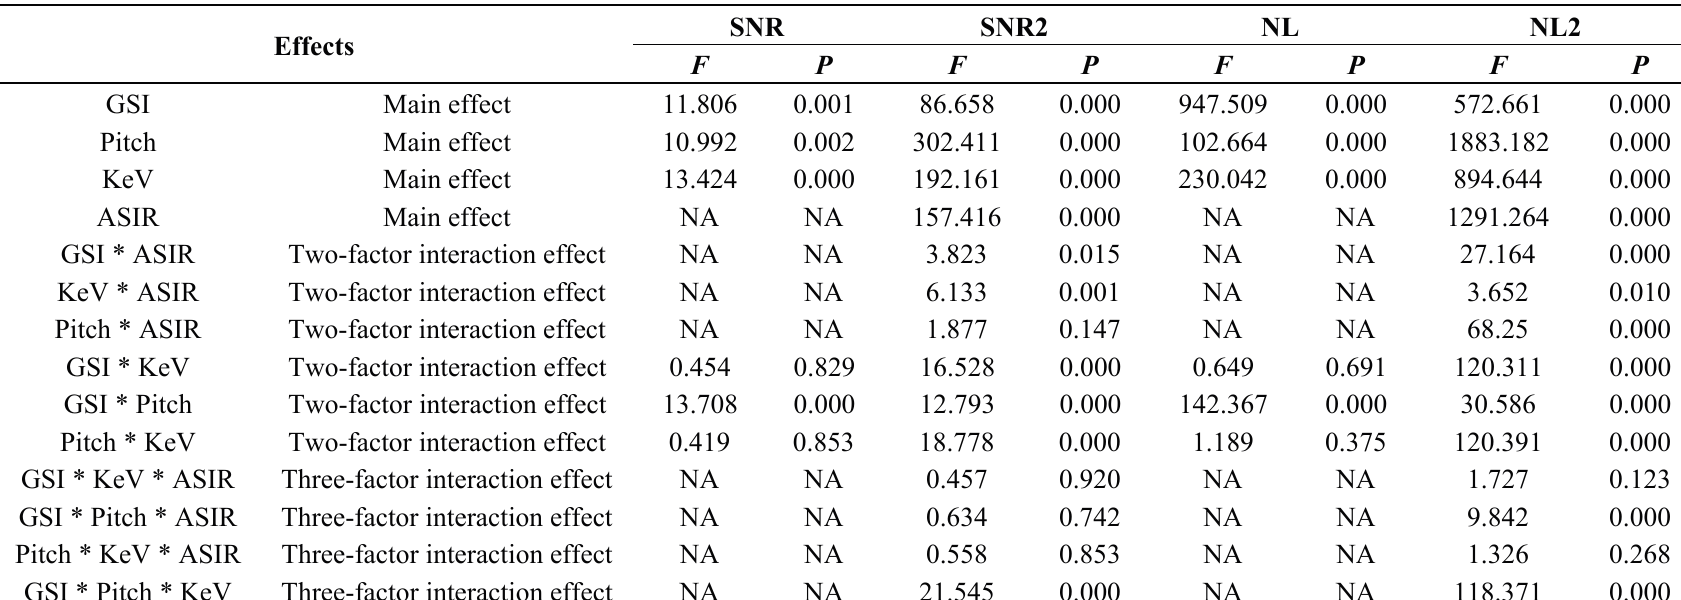
Table 1. Results of factorial